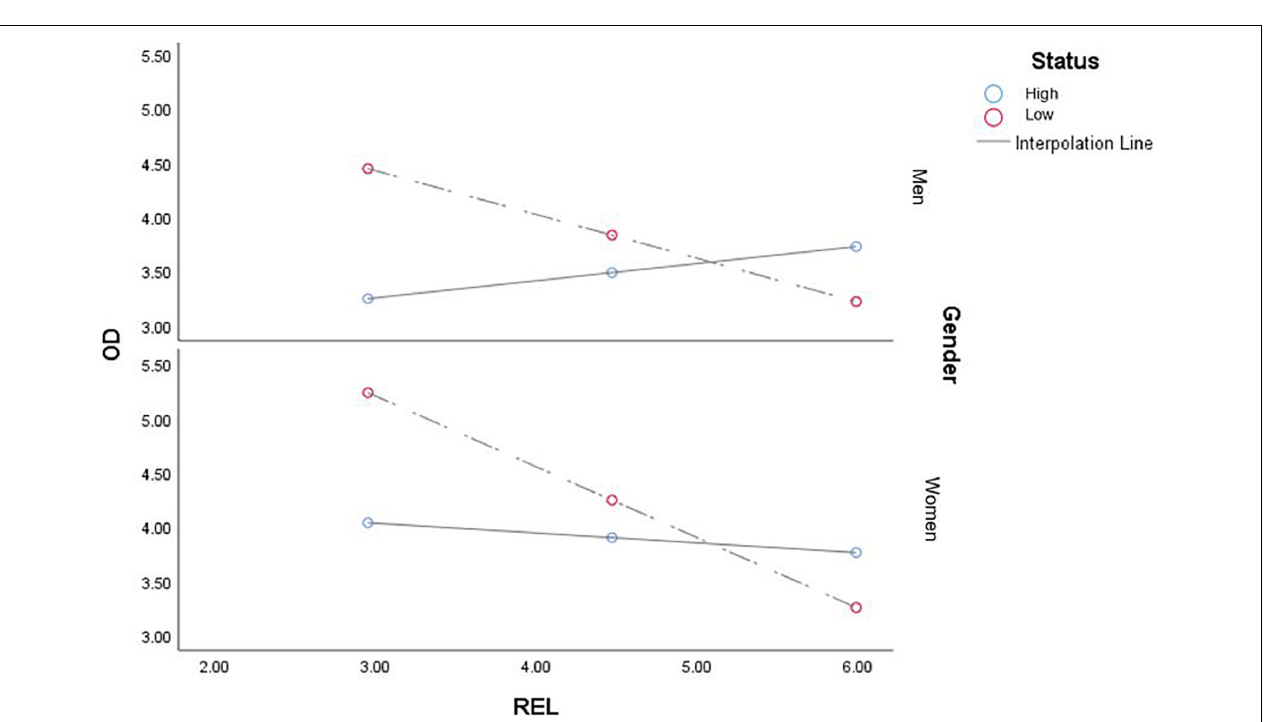
FIGURE 1 | Model of moderation between TSR, status, gender, and organizational dehumanization.